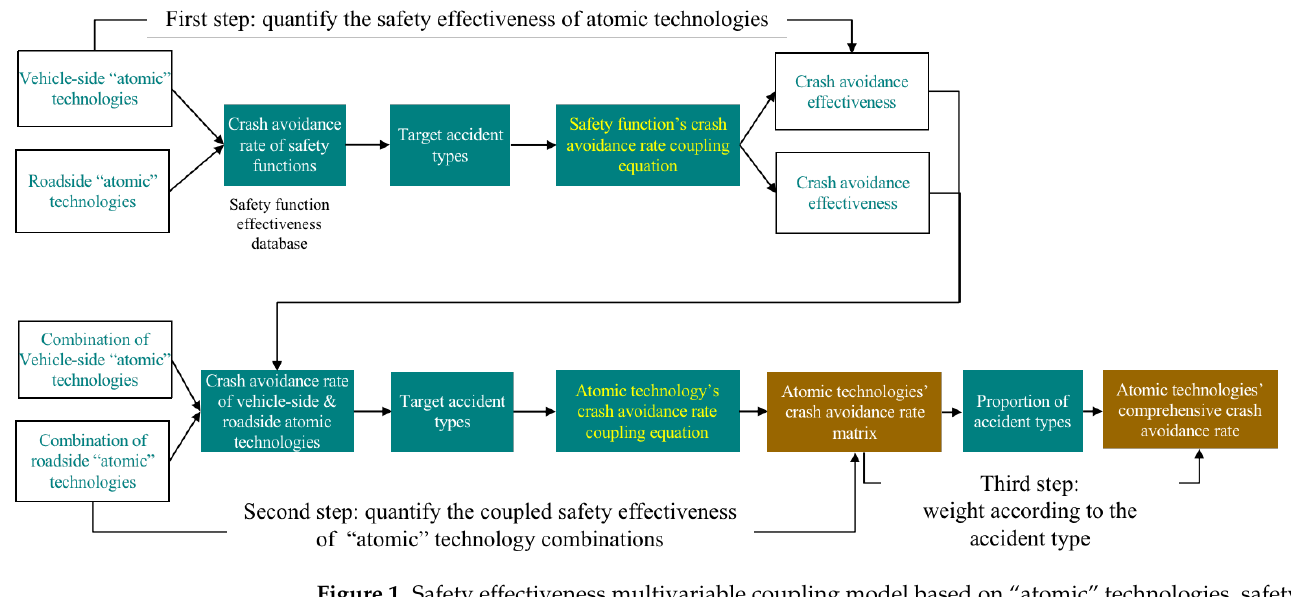
Figure 1. Safety effectiveness multivariable coupling model based on “atomic” technologies, safety functions, accident types, and crash avoidance effectiveness.